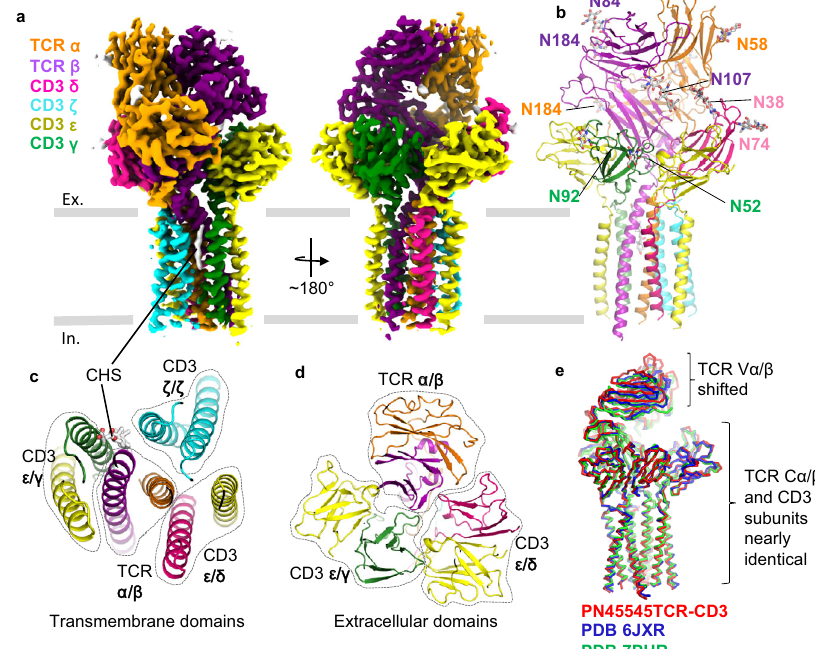
Fig. 1 | CryoEM structure of PN45545-TCR CD3 complex. a Two views of 3.0Å resolution cryoEM map of PN45545 TCR-CD3, with subunits in different colors. b Structure of PN45545 TCR-CD3, with N-linked glycans shown in stick repre- sentation. c top-down view of transmembrane domains. Putative CHS (cholesteryl hemisuccinate) molecule is shown as sticks. d top-down view of extracellular